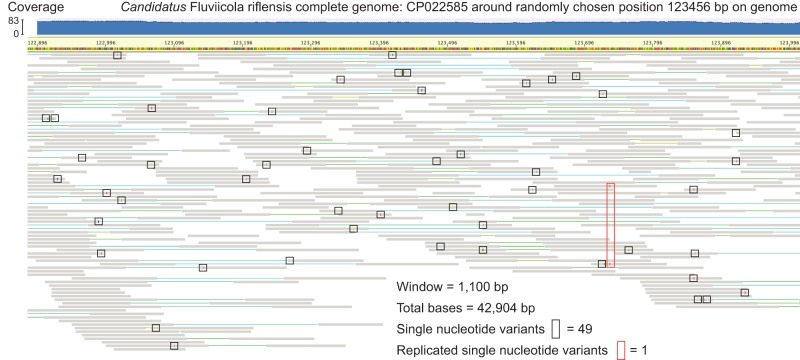
The low frequency of single-nucleotide variants (SNVs) of a recently published CMAG. A randomly chosen region, centered on position 123,456 (1100 bp in length) of the CMAG of Candidatus Fluviicola riflensis is shown with mapped reads (Banfield et al. 2017). SNVs that only occur once are indicated by black boxes, and the one replicated SNV is indicated by a red box. Clearly, the consensus sequence is well supported. The mapping of reads to the genome was performed by Bowtie 2 and visualized via Geneious.